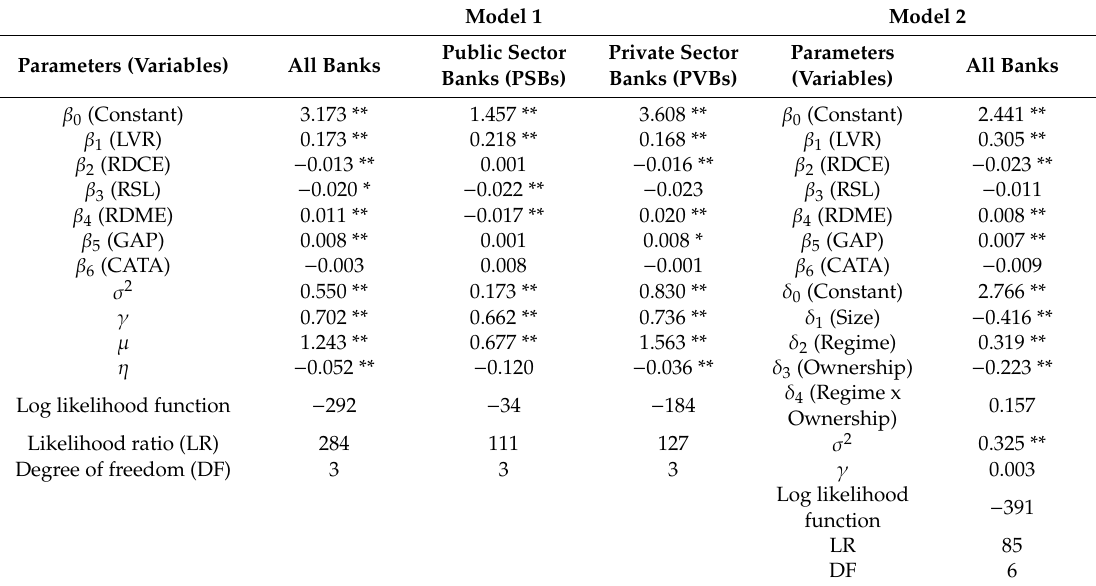
Table 2. Results of the Estimated